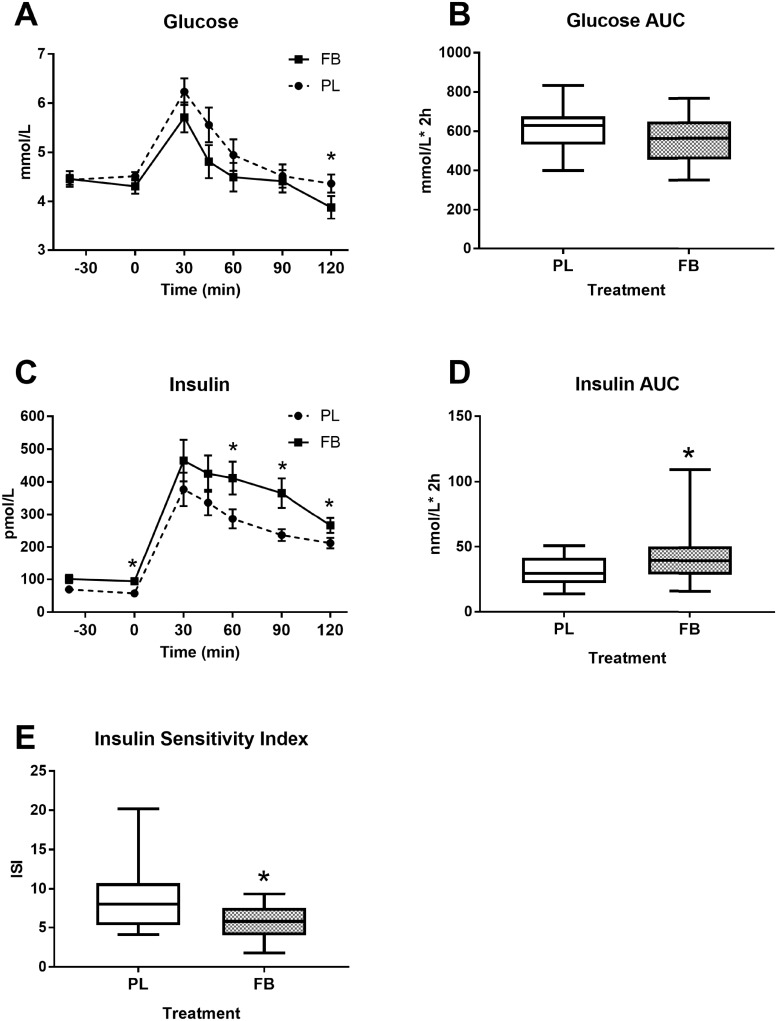
Plasma glucose and insulin excursion in response to an OGTT.Figures show glucose concentration over time (A), glucose AUC (B), insulin concentration over time; (C), insulin AUC (D) and the composite Matsuda index (E). Values represent the means ± SE, n = 20. *Indicates significant difference between PL and FB at p≤0.05.